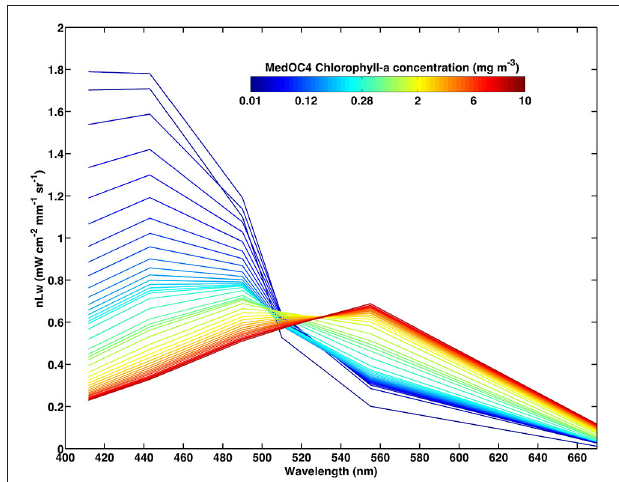
FIGURE 3 | Look-Up-Table for PHYSAT-Med OC-CCI algorithm. Normalized water-leaving radiance nLw as a function of wavelength for various MedOC4-Chla concentration (color scale, in mg/m 3 ) for the Mediterranean Sea (excluding Black Sea) during the study period (January 1998–December